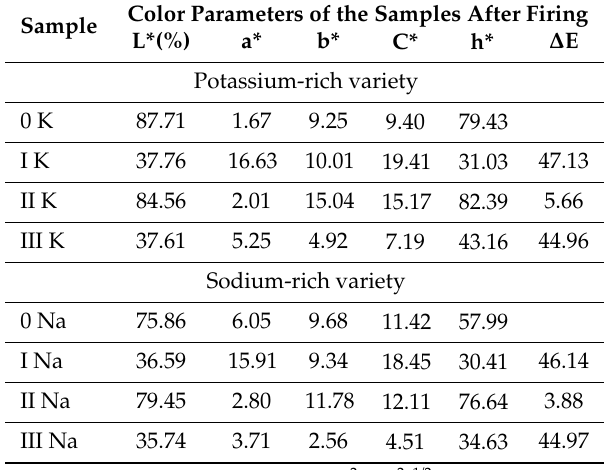
Table 4. Color parameters of the studied samples of di ff erent modulus K 2 O:Na 2 O after firing.